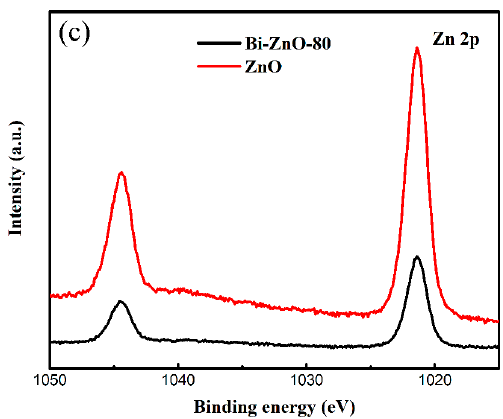
Figure 4. ( a ) XPS survey spectra, ( b ) Bi4f, and ( c ) Zn2p peaks of the Bi-ZnO-80 composite.